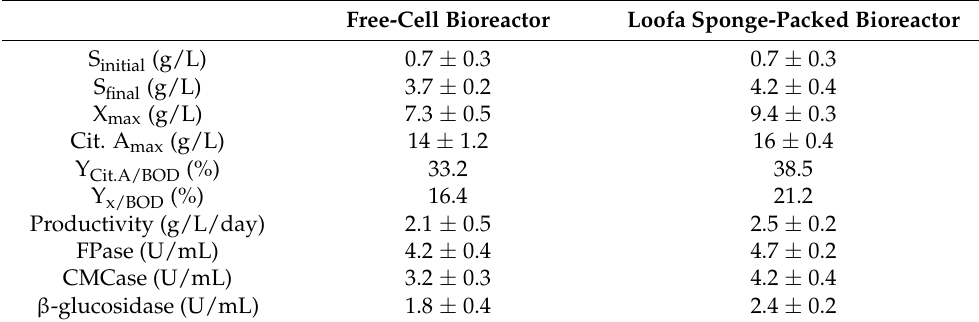
Table 2. Effect of cylindrical loofa sponge slices as an immobilizer for A. niger on fungal growth and metabolism after 7 days of batch fermentation using a column